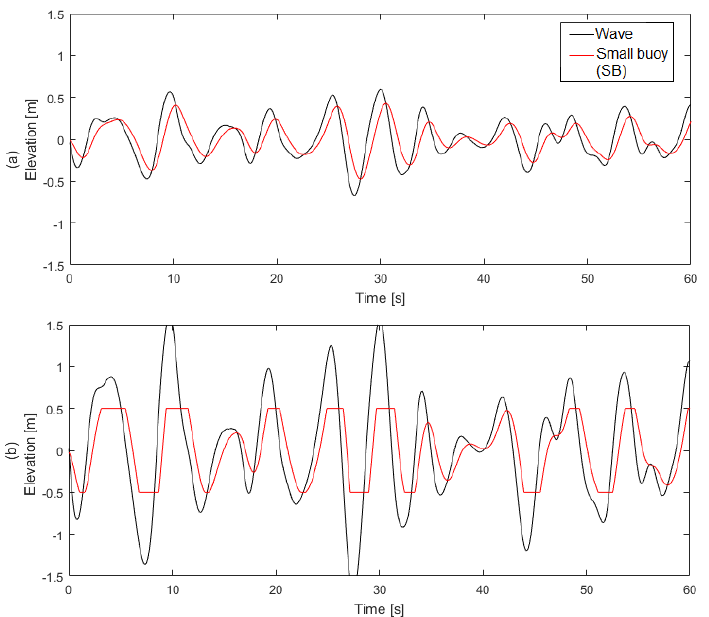
Figure 8. The vertical position of the small buoy (SB) in response to the relative position between buoy and wave inside the chamber. ( a ) Wave1; ( b ) Wave2. The SB clearly hits the end stops during Wave2.